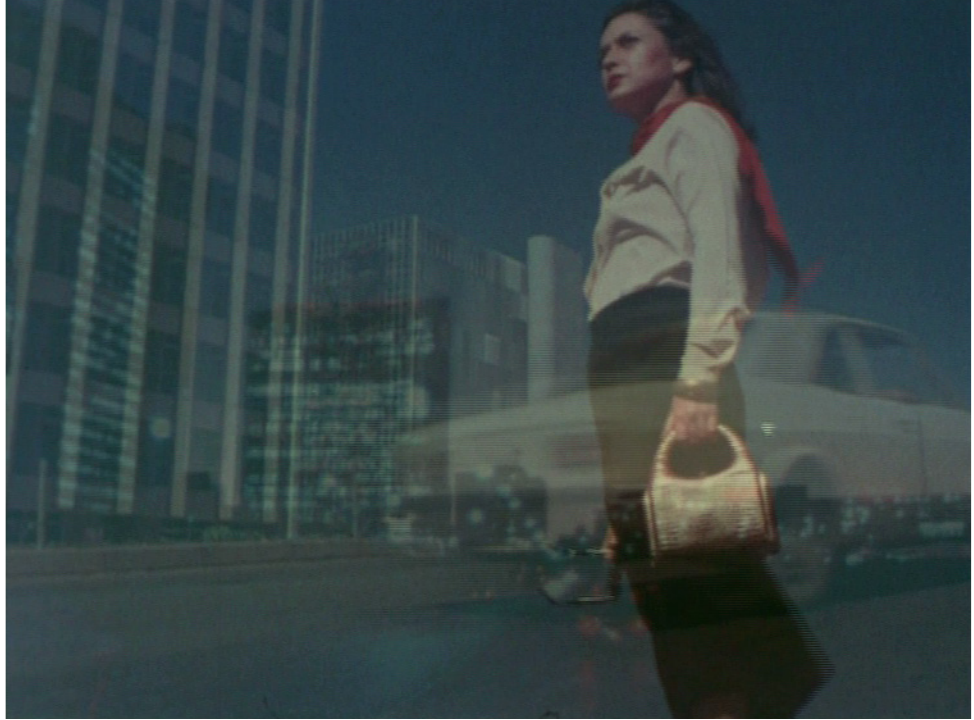
Figure 1. Still from Sacris Pulso (2008). Courtesy of the